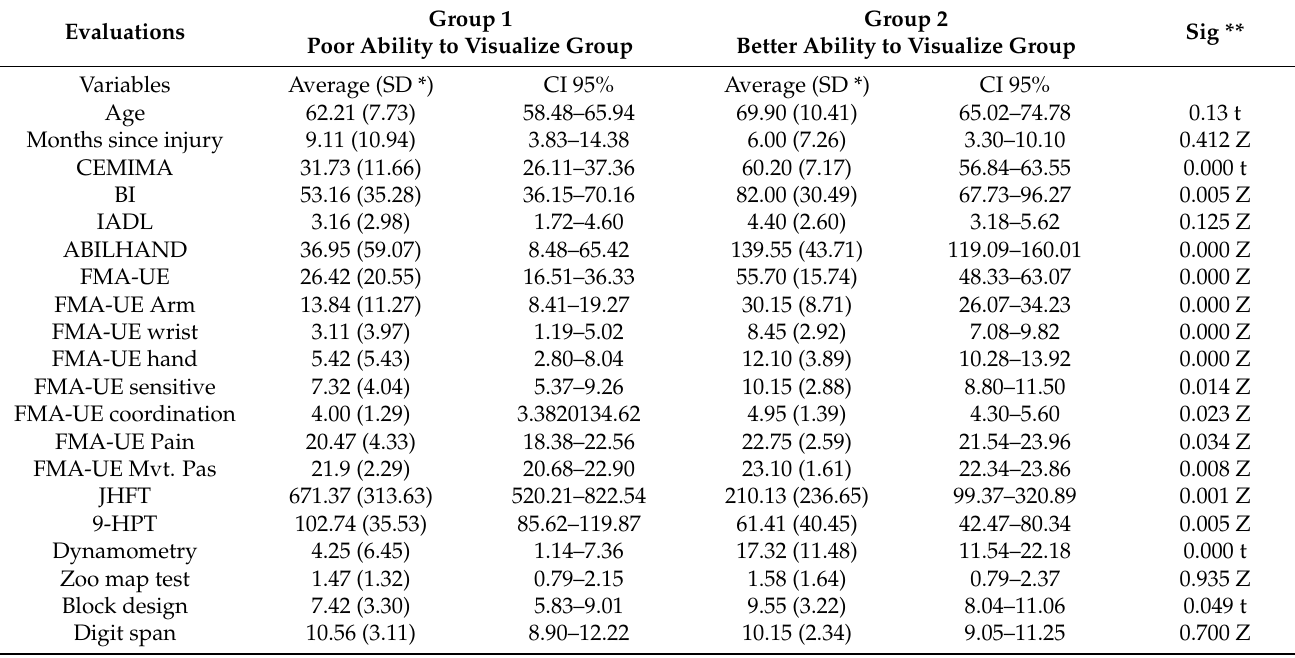
Table 1. Comparison among visualization of MI groups.